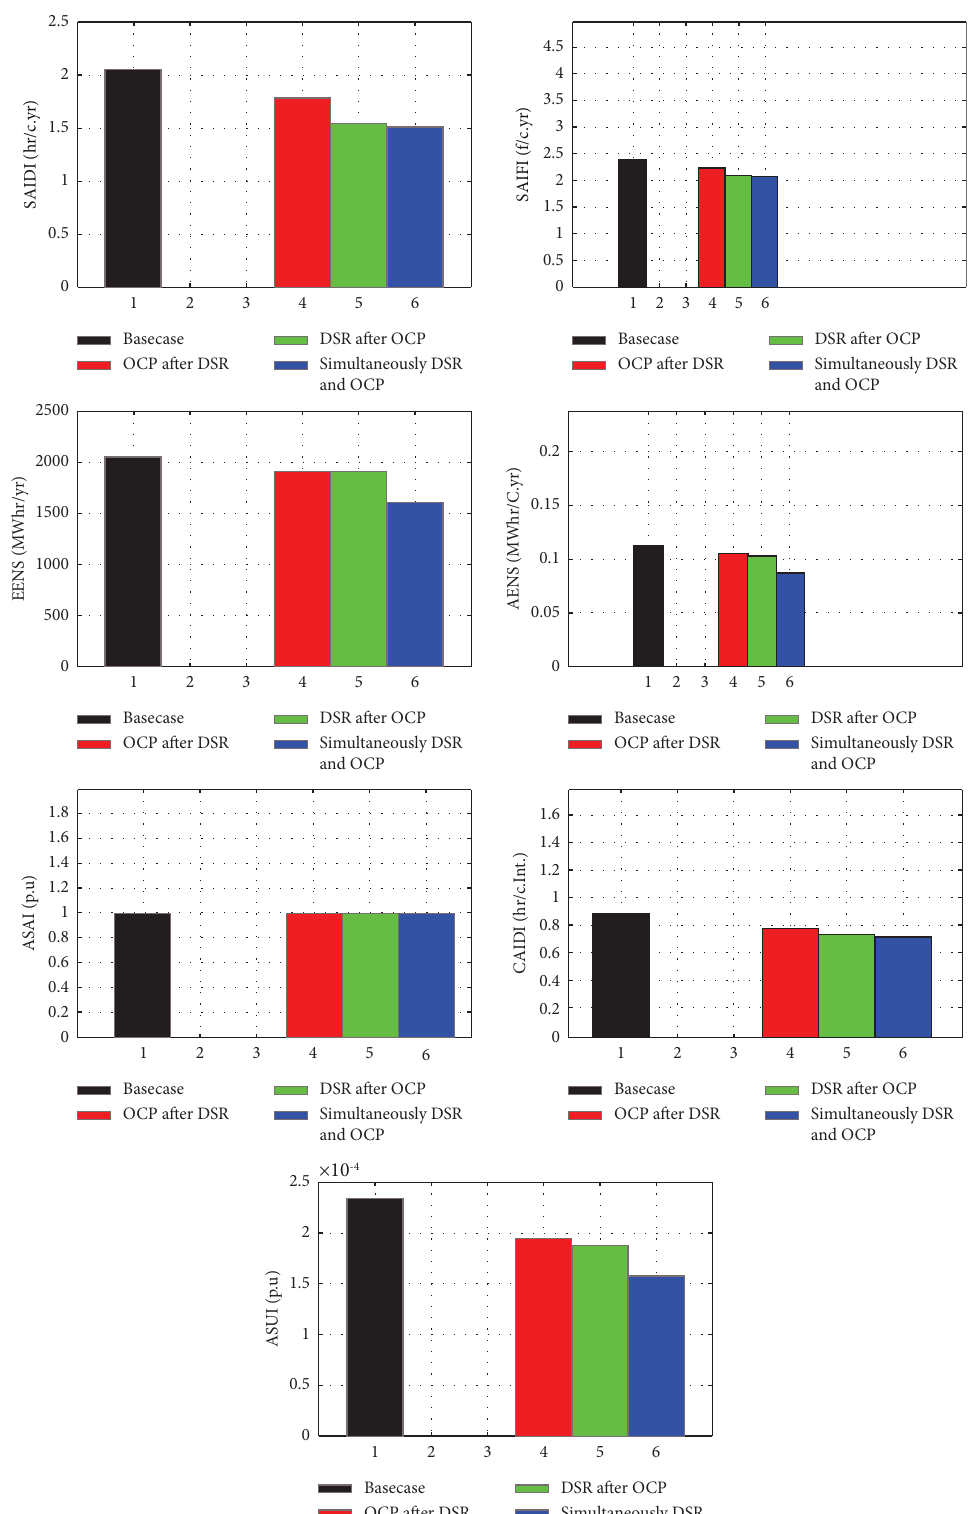
Figure 13: Reliability indices for 33-bus with using the BSSA algorithm for three scenarios with the base